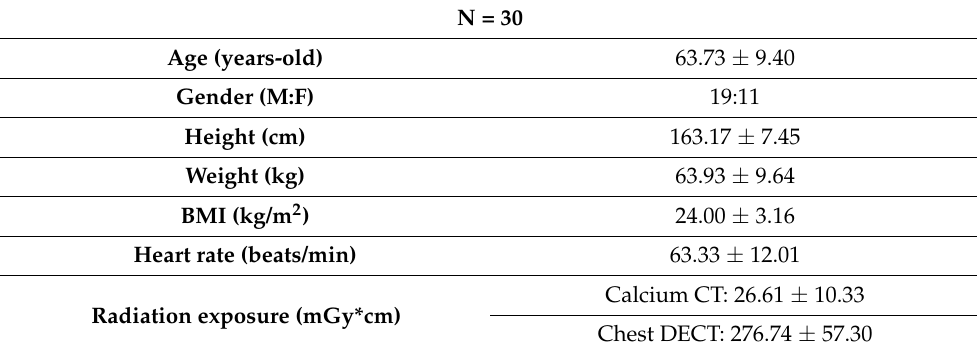
Table 2. Demographic data and baseline characteristics of the 30 patients enrolled.